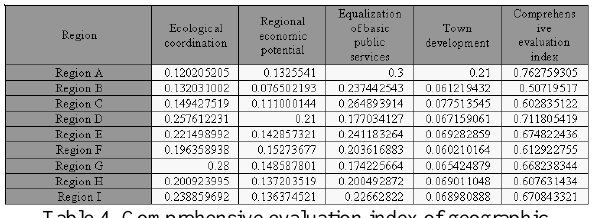
Table 4. Comprehensive evaluation index of